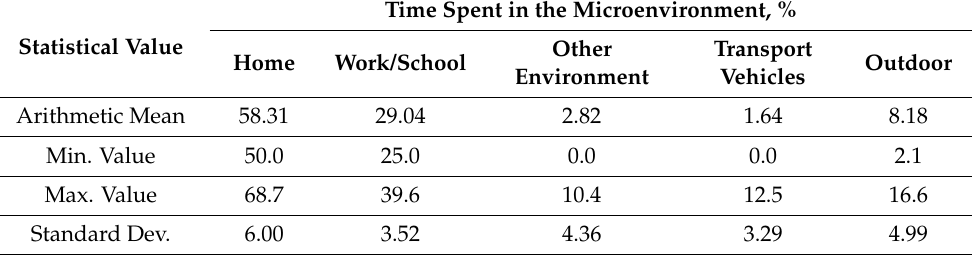
Table 5. Daily time budget of boys aged 14–15.